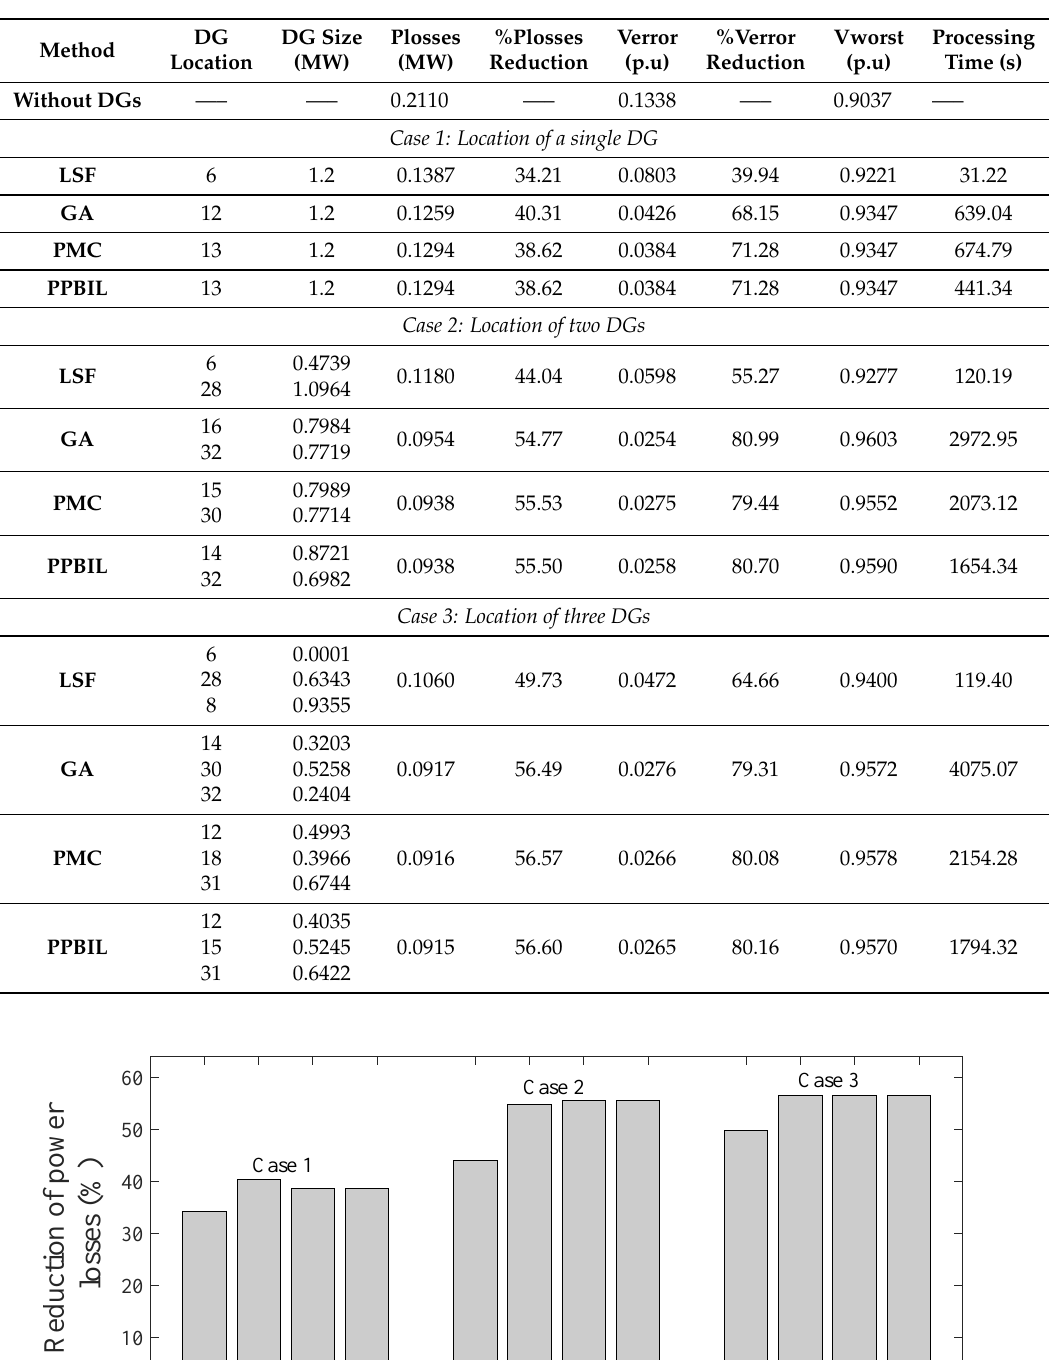
Table 3. Results of optimal location and sizing of Distributed Generators (DGs) for the test system with 33 buses.